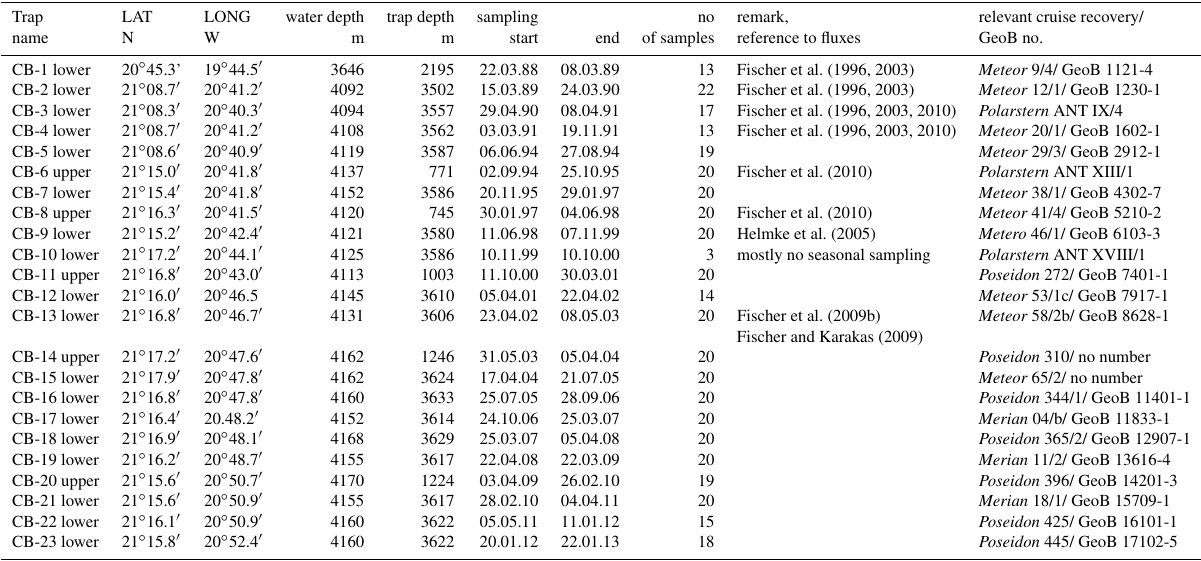
Table 1. Deployment data of the moorings and traps at the mesotrophic sediment trap site CB, Cape Blanc, Mauritania. Associated ships’ cruises and references to earlier publications on fluxes are indicated. Trap LAT LONG water depth trap depth sampling no remark, relevant cruise recovery/ name GeoB